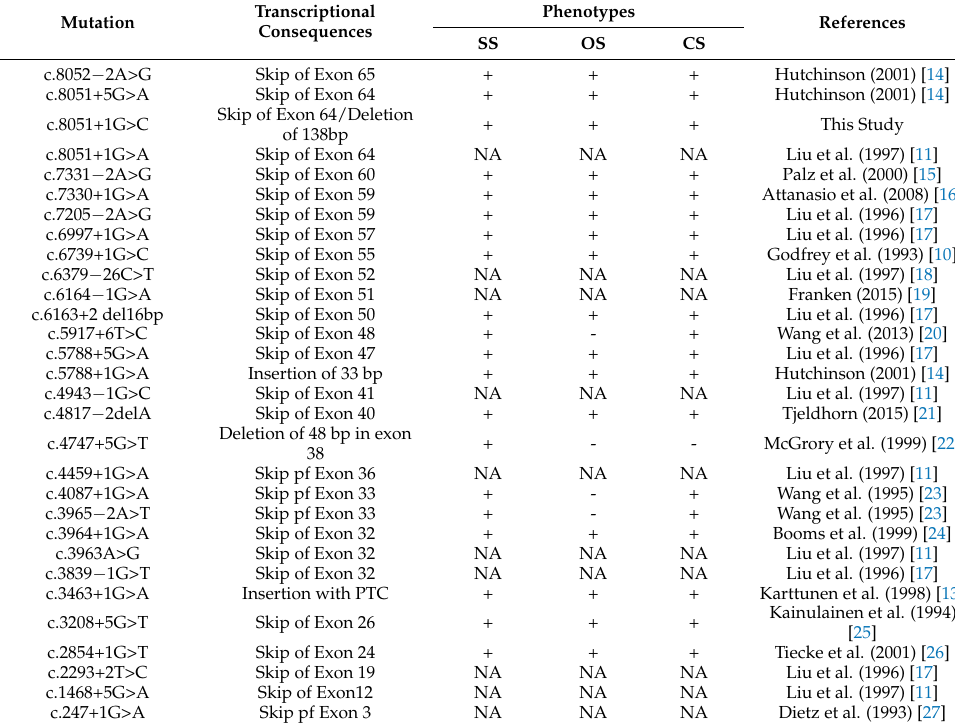
Table 1. Summary of the experiment-based transcriptional consequences of splice-altering mutations of